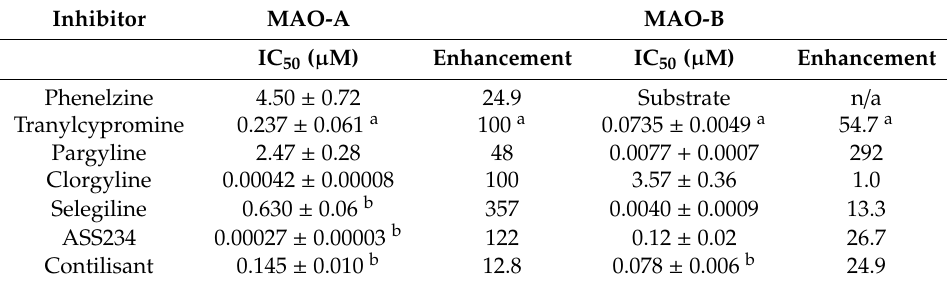
Table 2. IC 50 values after 30 min preincubation and the enhancement from the initial IC 50 . Inhibitor